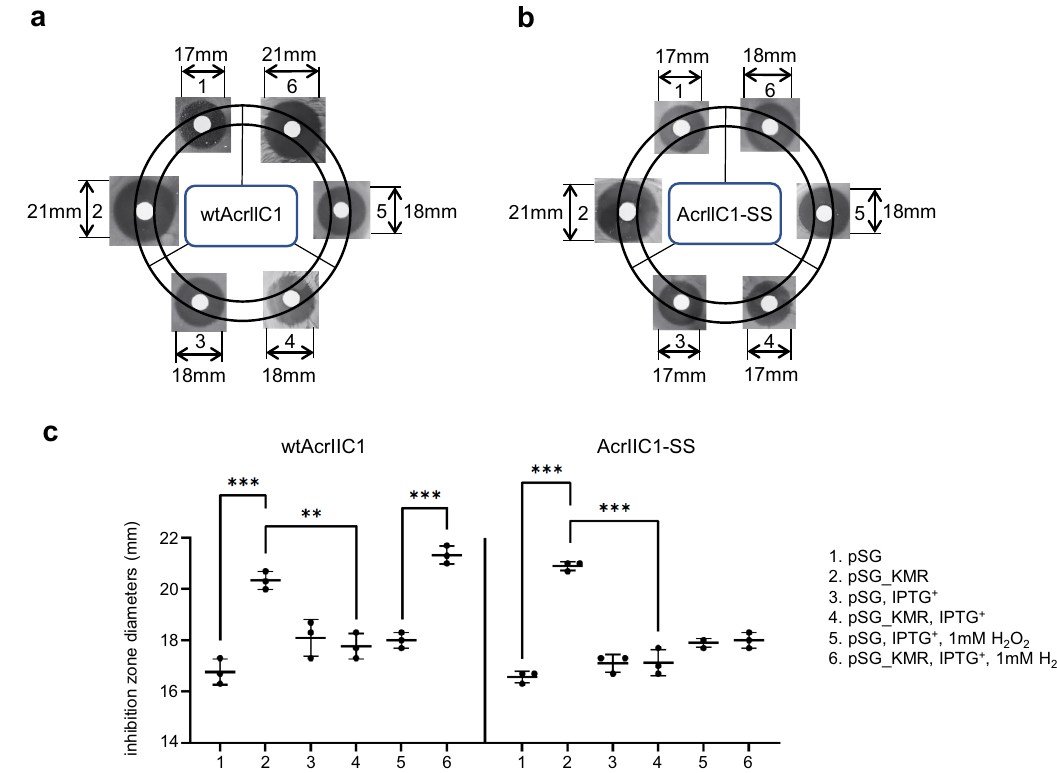
Fig. 6 | Antimicrobial susceptibility assays accessing wtAcrIIC1 and AcrIIC1-SS activities in vivo. a Panels 1, 2, assays without wtAcrIIC1 expression: pSG repre- sents negative control carrying no spacer; pSG_KMR represents kmR spacer- introduced plasmid. The gene-editing ability of the two-plasmid system pCas-pSG was con fi rmed by a signi fi cant increase in the size of the inhibition ring relative to thenegativecontrol,witharepresentativediameterof21mmvs17mm.Panels3,4, assays with wtAcrIIC1 induced by IPTG. Co-expression of wtAcrIIC1 restored the inhibition ring because it binds to and deactivates Cas9. Panels 5, 6, assays with wtAcrIIC1 induced and 1mM H 2 O 2 stimulus. wtAcrIIC1 failed to restore the inhibi- tion ring under H 2 O 2 stimulus due to the loss of its activity under the oxidative environment. b Co-expression of AcrIIC1-SS can restore the inhibition ring under various redox environments because its activity is resistant to redox fl uctuation.